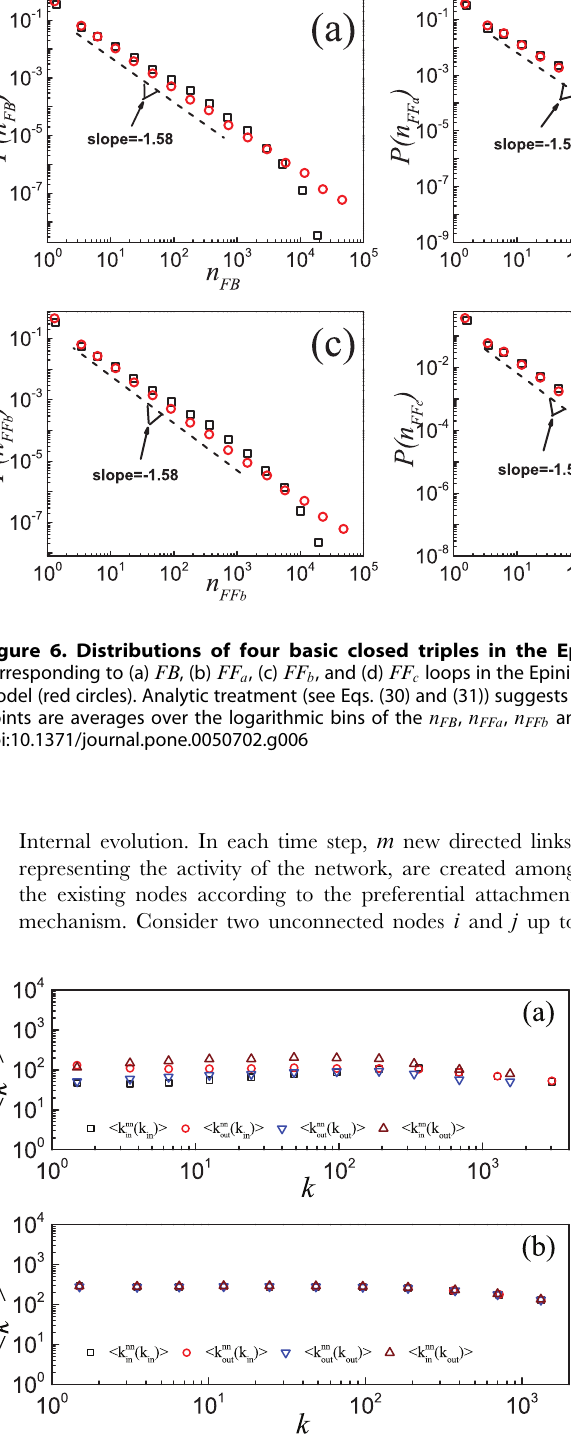
Figure 7. Degree correlations in the Epinions social network and the model. Results of degree correlations as measured by four quantities corresponding to the average nearest neighbor degree v k nn ( k in ) w (squares), v k nn ( k in ) w (circles), v k nn ( k out ) w (triangles), in out out and v k nn ( k out ) w (inverted triangles) for (a) the Epinions social network in and (b) simulated network based on the model. Data points are averages over the logarithmic bins of the indegree k in or outdegree k out